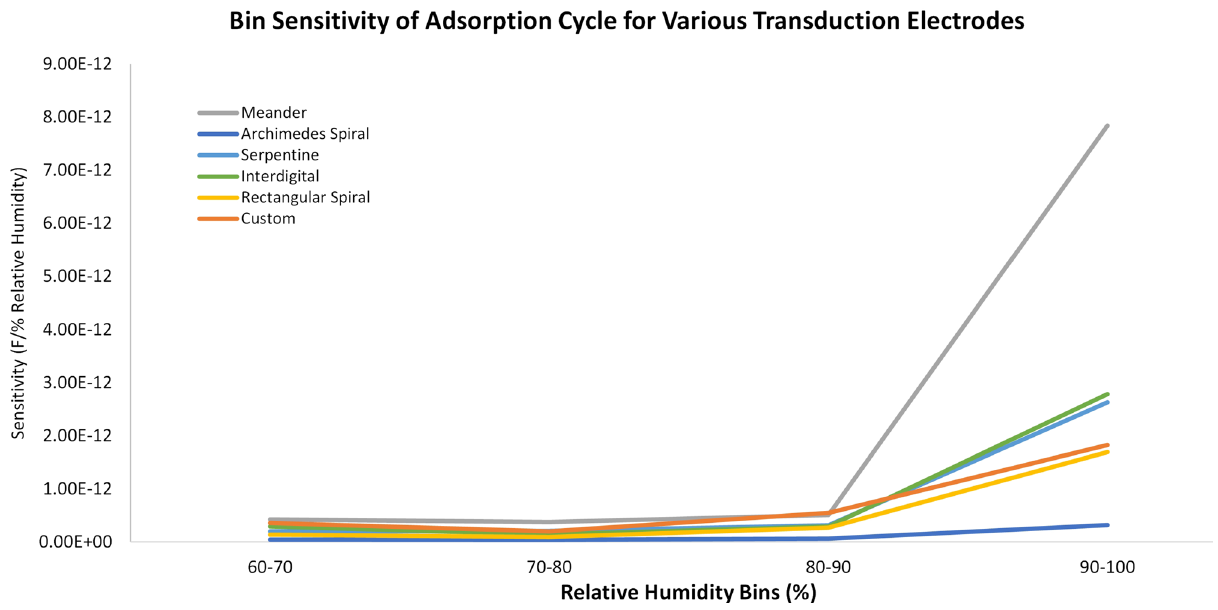
Figure 6. Bin sensitivities of all six transduction